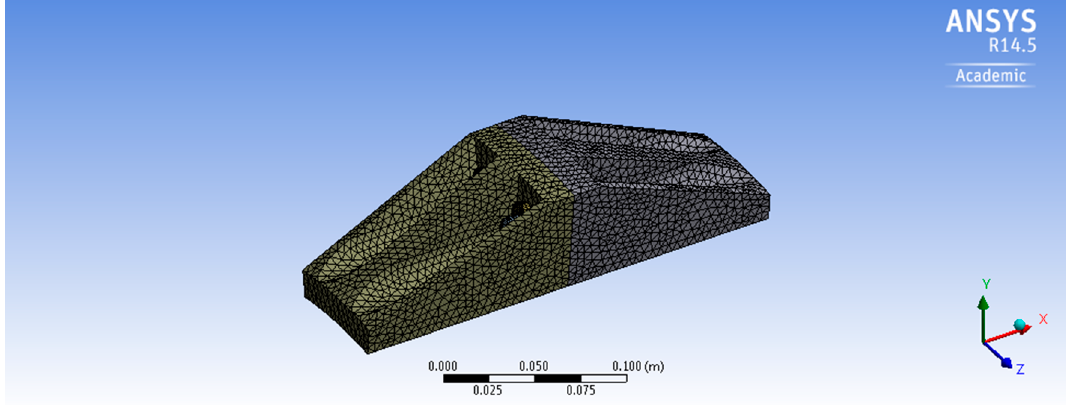
Figure 4. A complex geometry is generated to make a stiffer